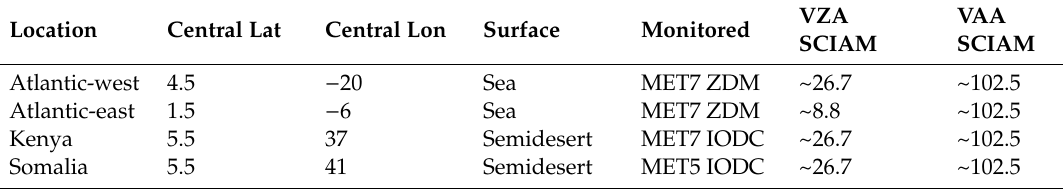
Table 7. Locations of the areas considered for finding potentially ray-matched SCIAMACHY-MVIRI collocations (ZDM and IODC) that are exploited in this study. The viewing zenith angle (VZA) and viewing azimuth angle (VAA) of considered SCIAMACHY observations are